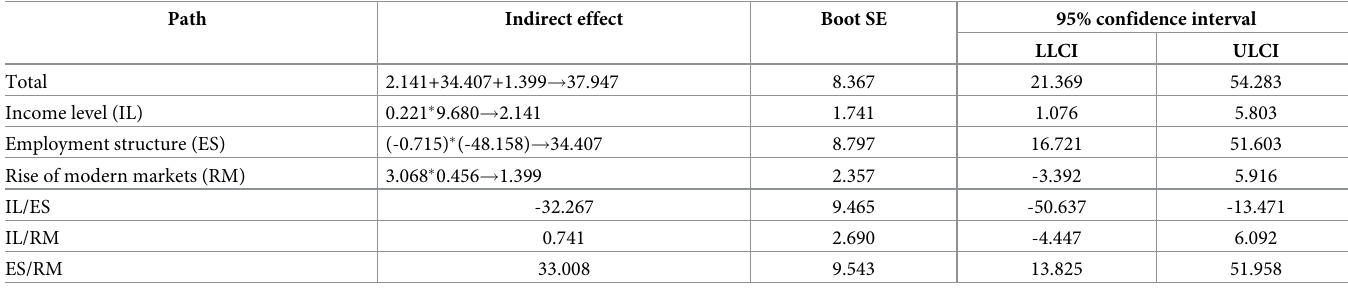
Table 7. The test results of the mediating effect using the percentile bootstrap method.